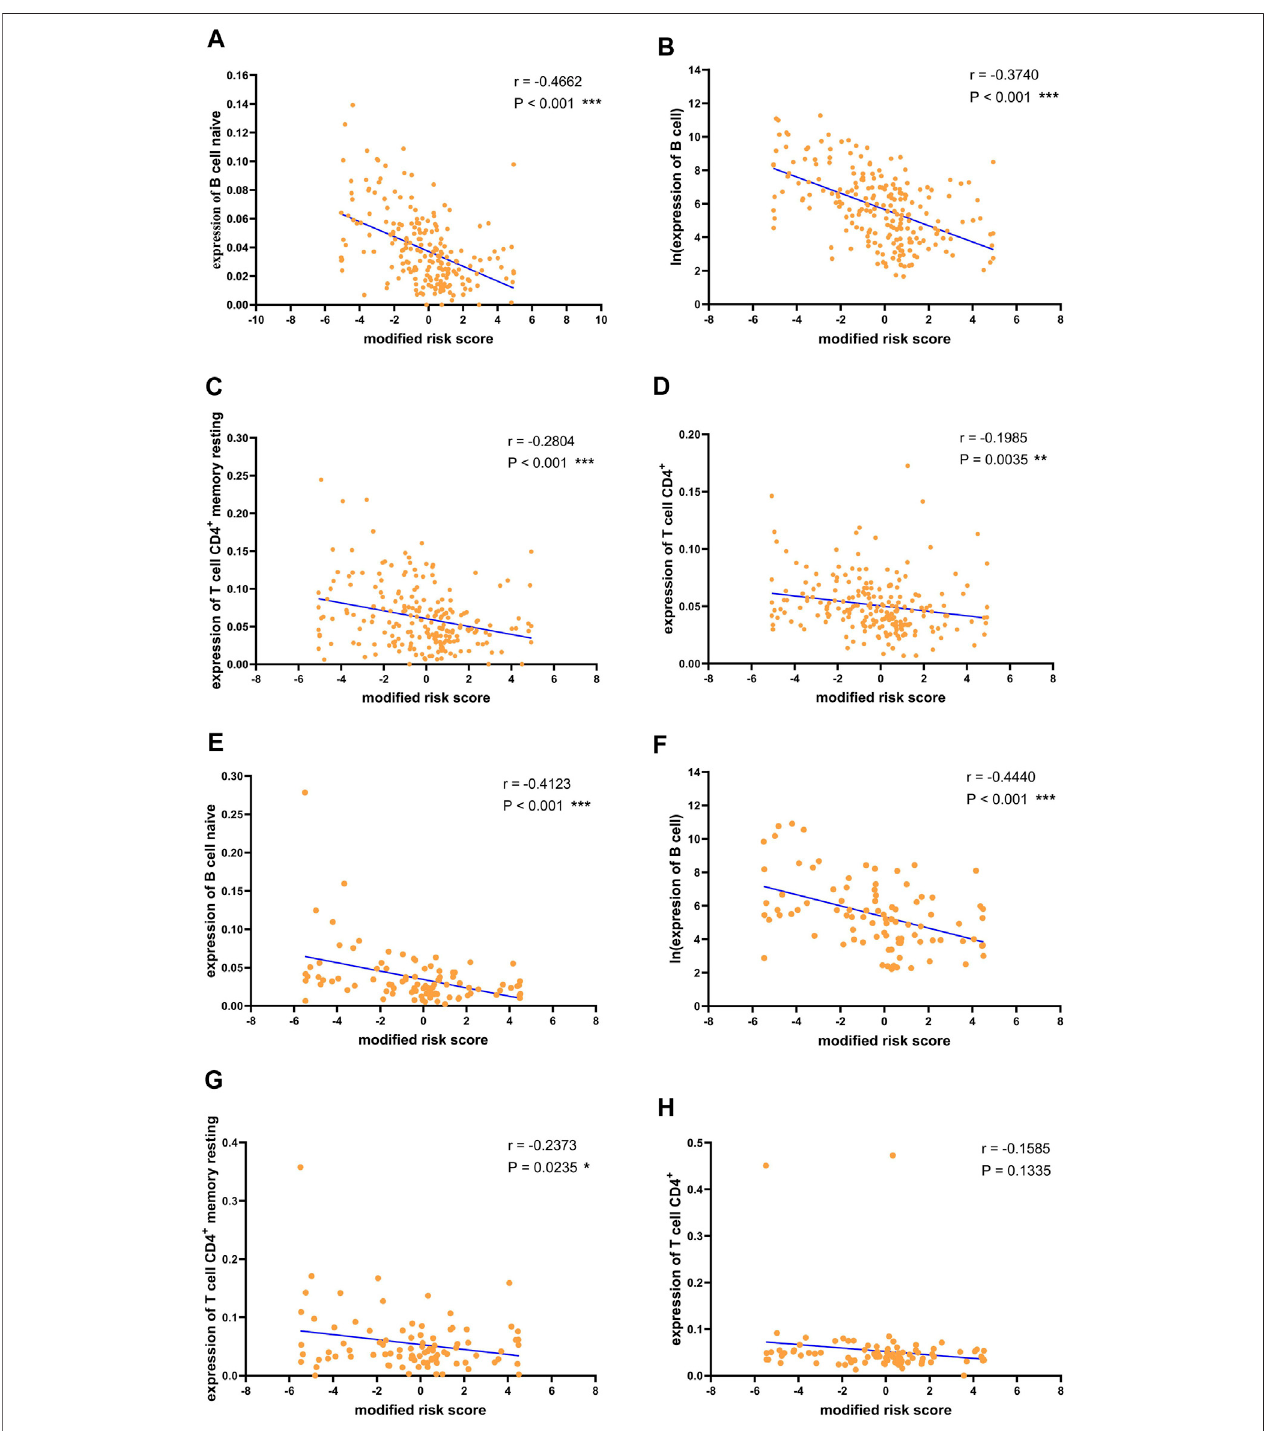
FIGURE6| Correlationbetweenriskscoresandimmunecells.Correlationbetweenriskscoreand (A) Bcellnaive (B) Bcell (C) TcellCD4 + memoryresting (D) Tcell CD4 + in the training data. Correlation between risk score and (E) B cell naive (F) B cell (G) T cell CD4 + memory resting (H) T cell CD4 + in the validation data. For convenience of display, the risk score is subtracted from the median and magni fi ed 10 times to obtain the modi fi ed risk score. * p < 0.05, ** p < 0.01 and *** p < 0.001.